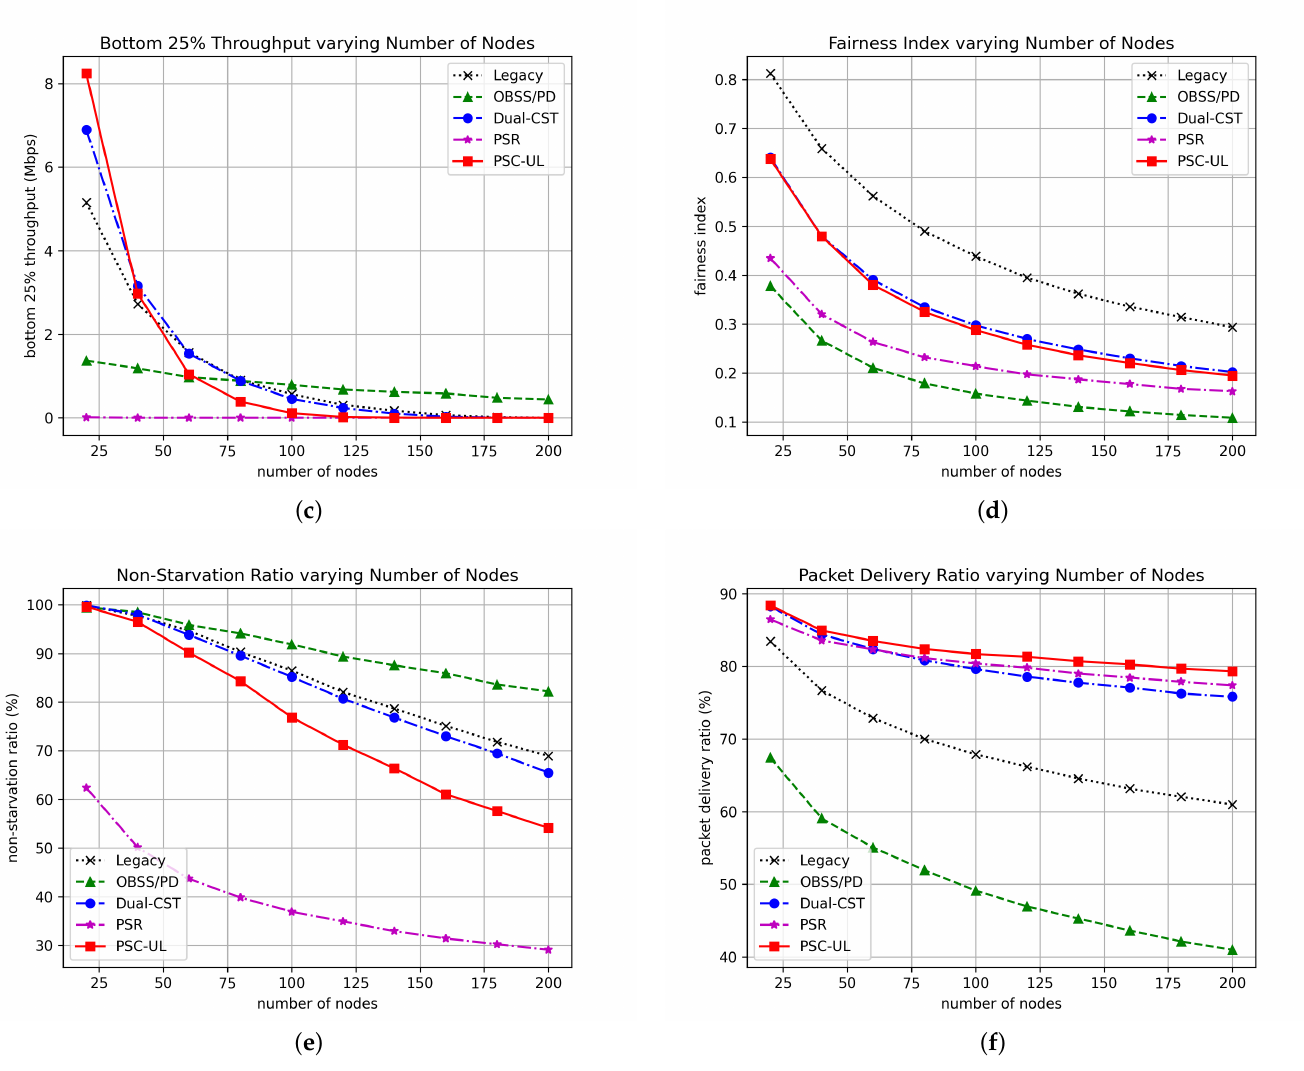
Figure 8. Performance of methods varying number of nodes. ( a ) Total throughput; ( b ) Bottom 50% throughput; ( c ) Bottom 25% throughput; ( d ) Fairness; ( e ) Non-starvation Ratio; ( f ) Delivery